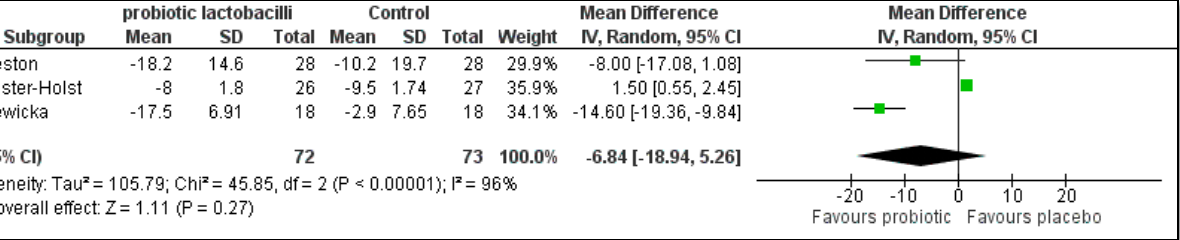
analysis as the treatment time was only 4 weeks.